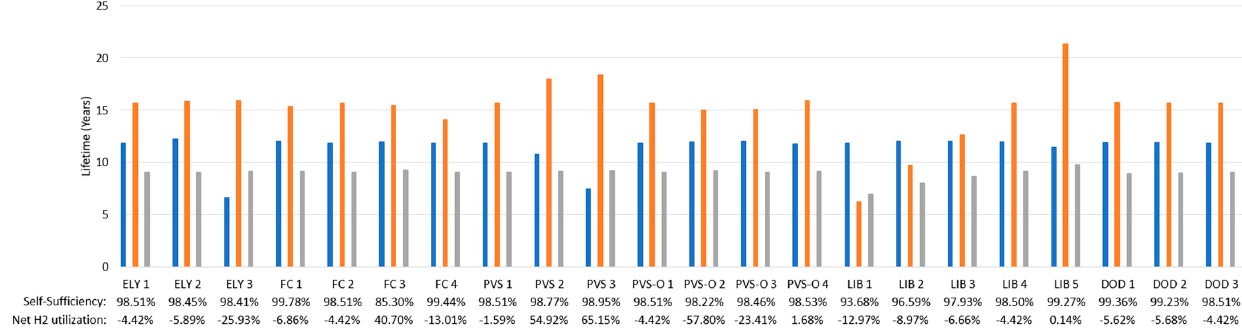
Figure 19. Lifetime comparison between all parameter studies.